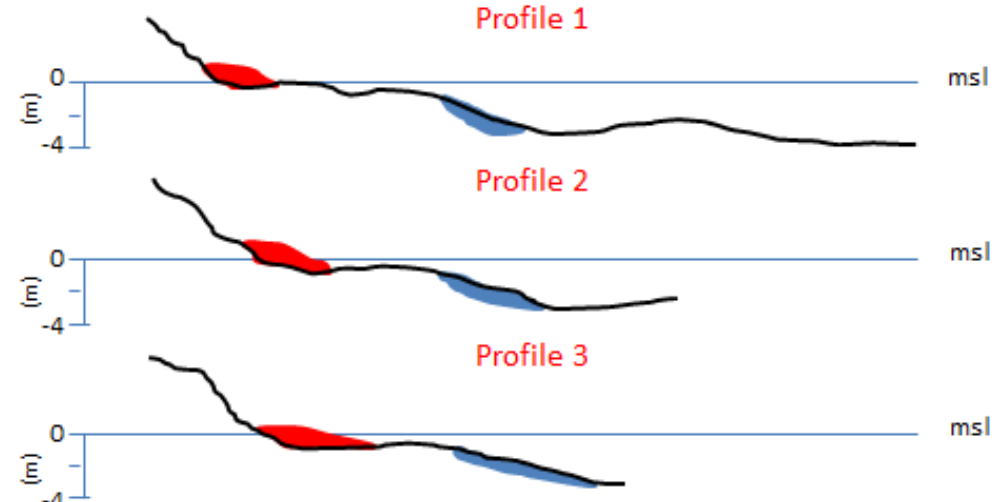
Figure 12. A simplified sketch of the dredging area (blue) and nourishment area (red) are reported along three profiles of the beach-dune system (black line) in front of Fogliano Lake (norther part of the studied area more exposed to erosion and tourists).